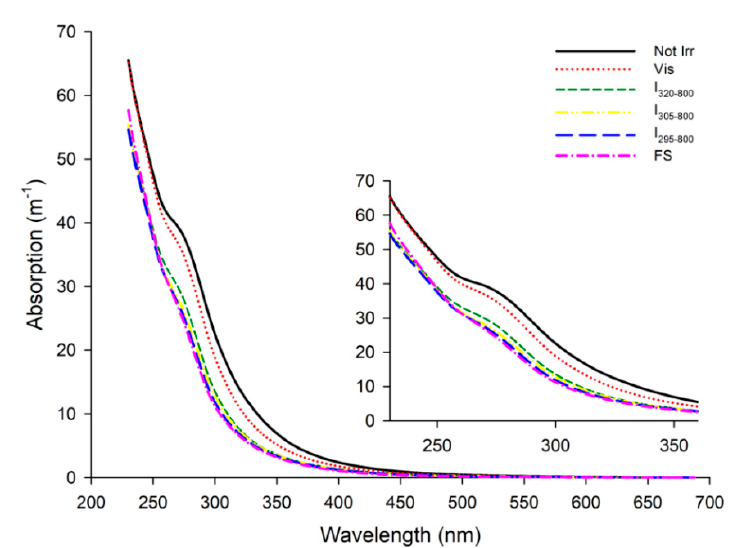
Figure 1. Absorption spectra of chromophoric dissolved organic matter (CDOM) released by E. huxleyi measured before and after the irradiation with the different cutoff filters. A zoom of the spectra between 230 and 400 nm is also shown, because this is the region where the major differences were observed. For each treatment the spectrum shown is the average spectra of the replicates.